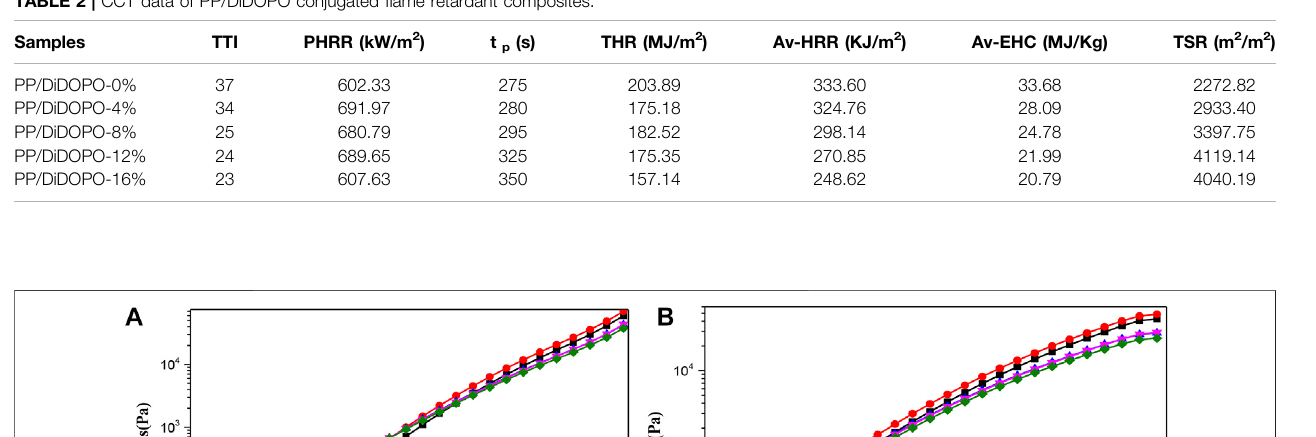
Frontiers in Chemistry |